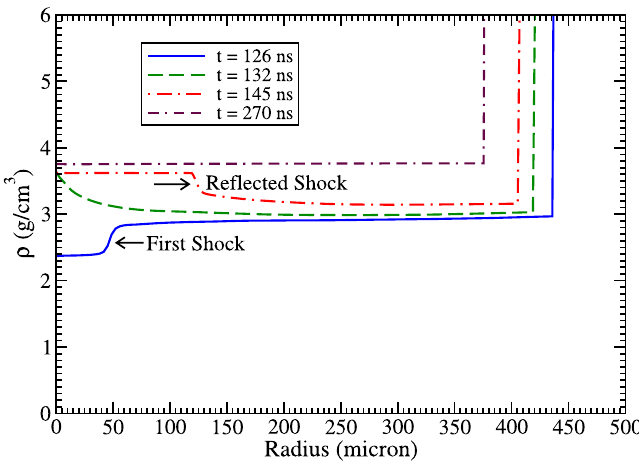
Figure 9. Density vs radius at different times at the middle of the axis.